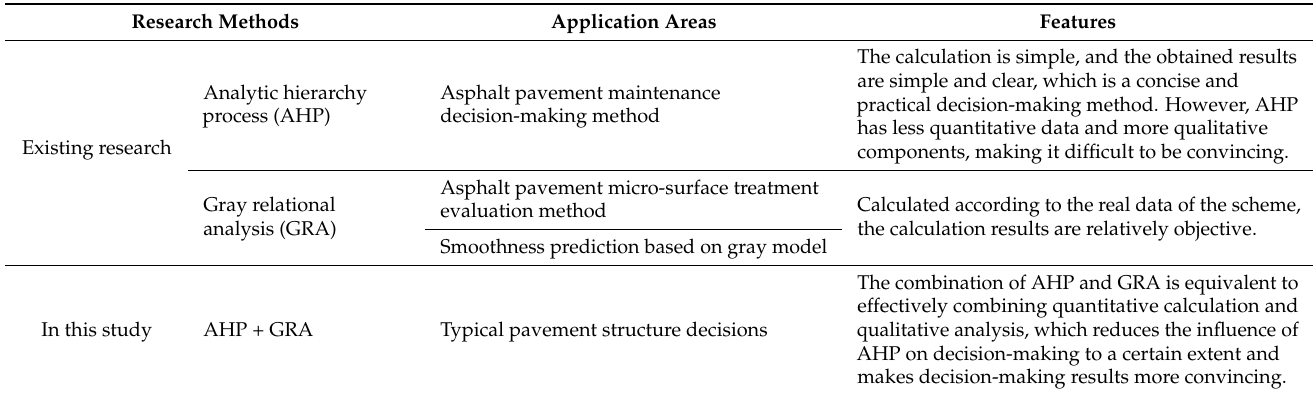
Table 1. Comparison of this study with existing research